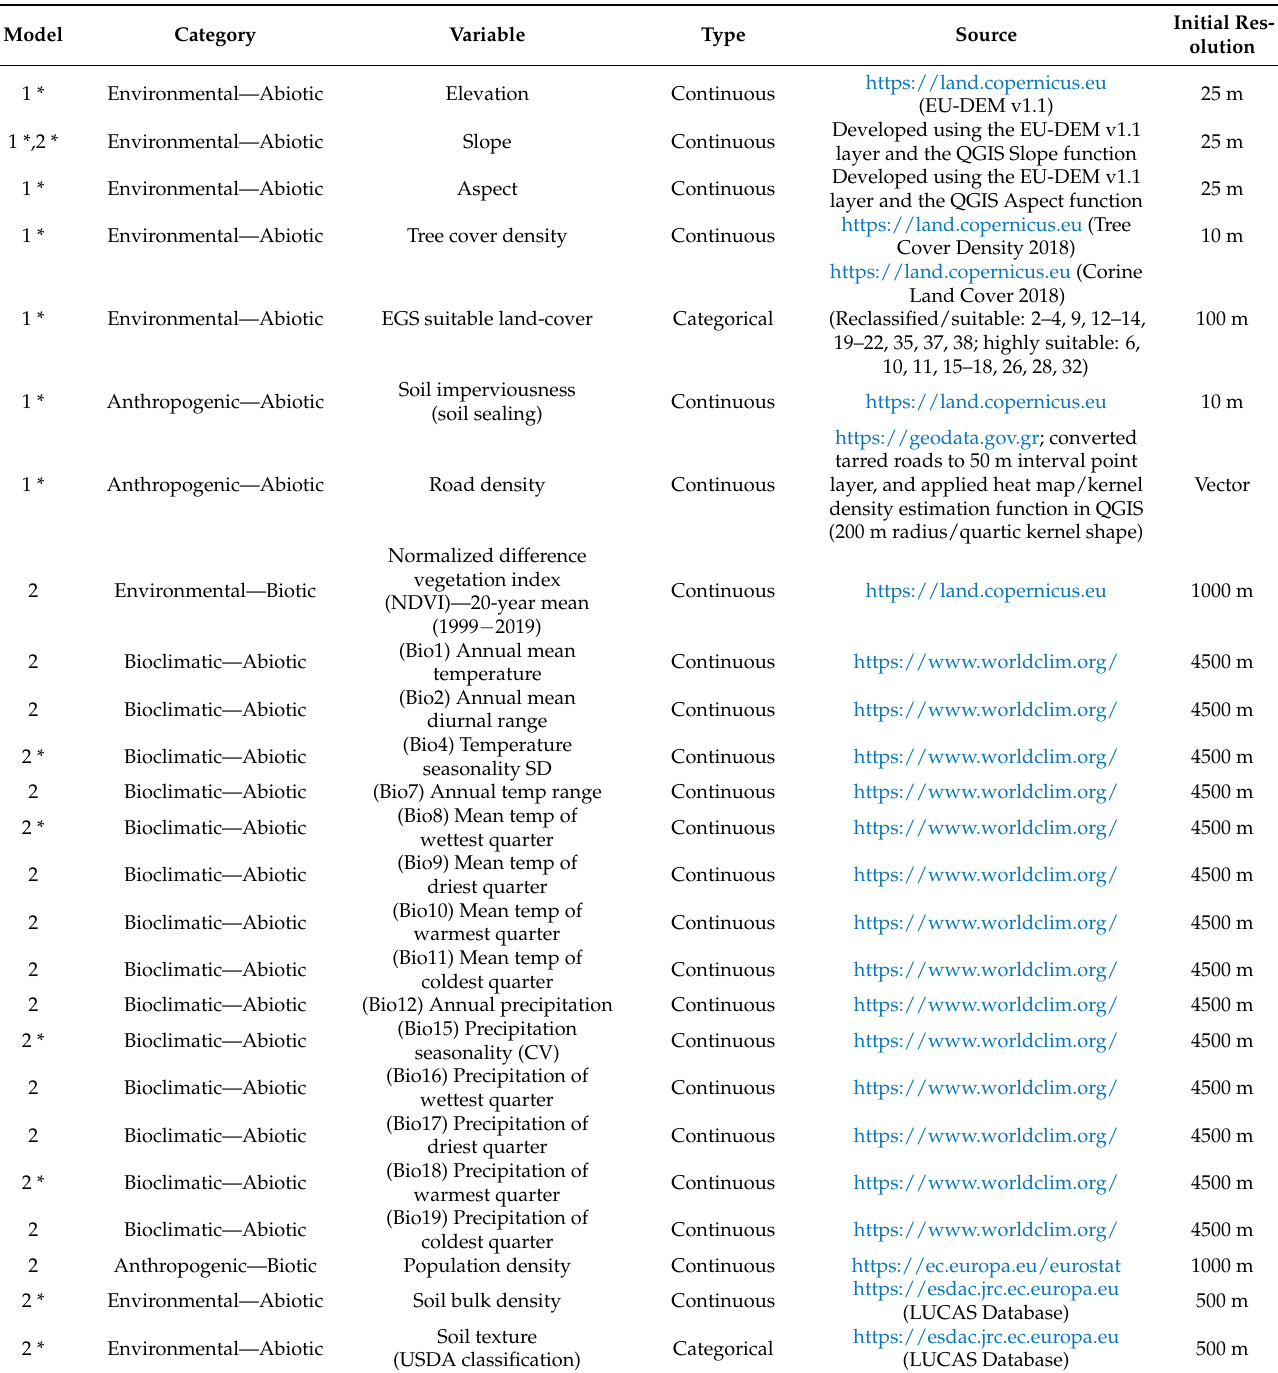
Table 1. Bioclimatic, environmental, and anthropogenic variables considered in either or both of the Spermophilus citellus ecological niche models (model 1: habitat availability 100 m resolution; model 2: habitat suitability 4500 m resolution). Note: asterisks mark models in which a given variable was used in the final